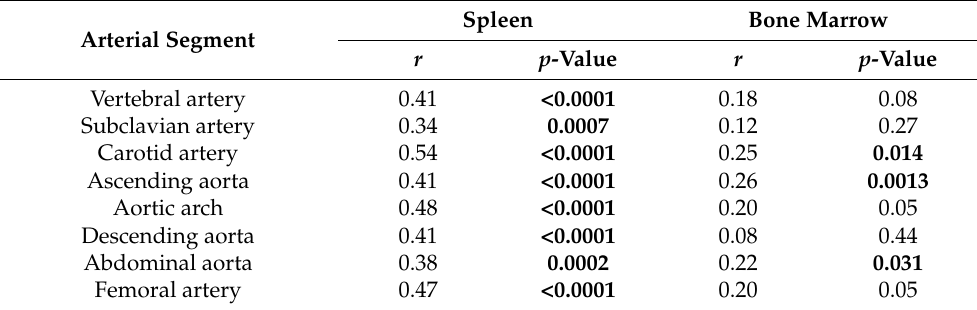
Figure 4. ( A ) Uptake in the descending aorta correlated significantly with the uptake in the spleen. ( B ) C-reactive protein as a marker of systemic inflammatory response correlated significantly with vessel wall-to-liver ratio (VLR) of abdominal aorta. ( C ) VLR of descending aorta correlated with the prednisone dosage. Table 4. Correlations between the standardized uptake value (SUV) of each arterial segment, spleen, and bone marrow ( n =